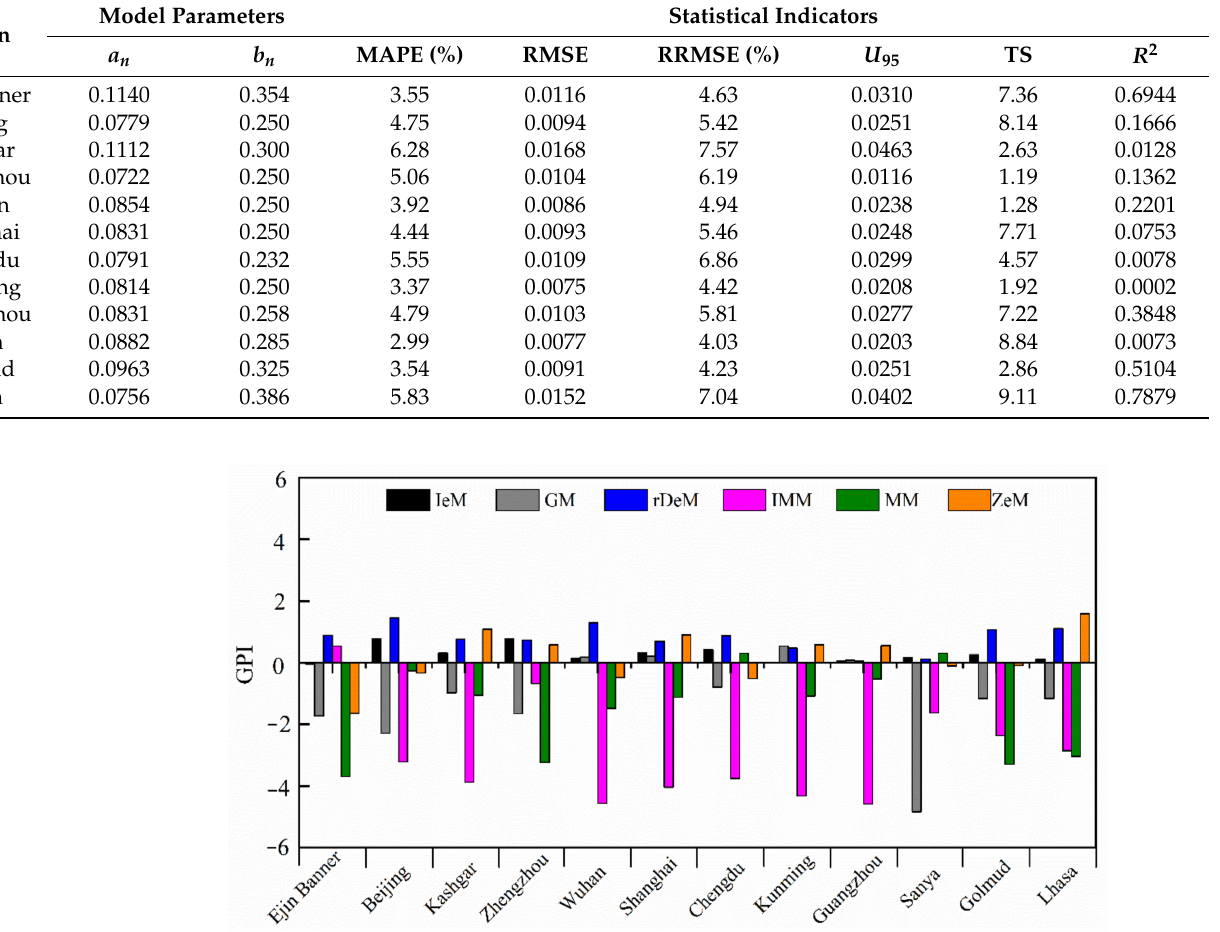
Figure 8. GPI values for each station when DeM is replaced by rDeM for model